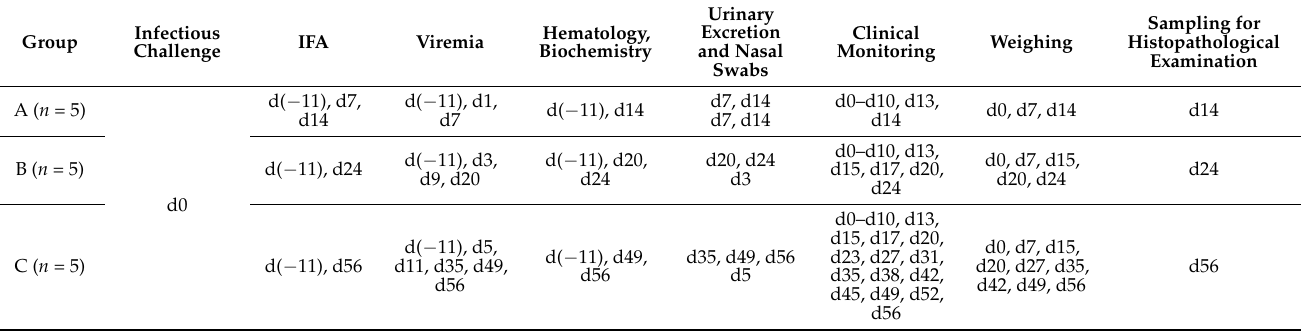
Table 1. Experimental design of the cat FeMV-GT2 infection